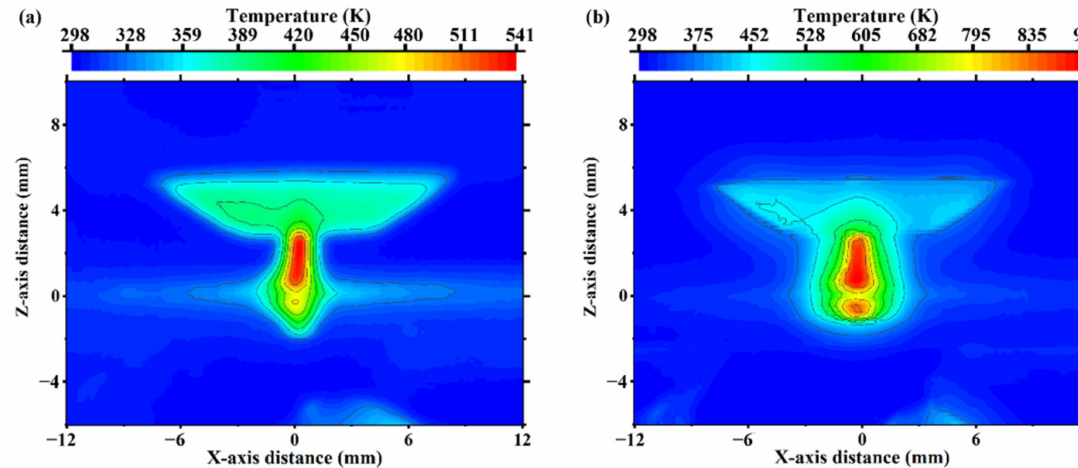
Figure 6. Temperature distribution of the arc with currents of ( a ) 20 A and ( b ) 40